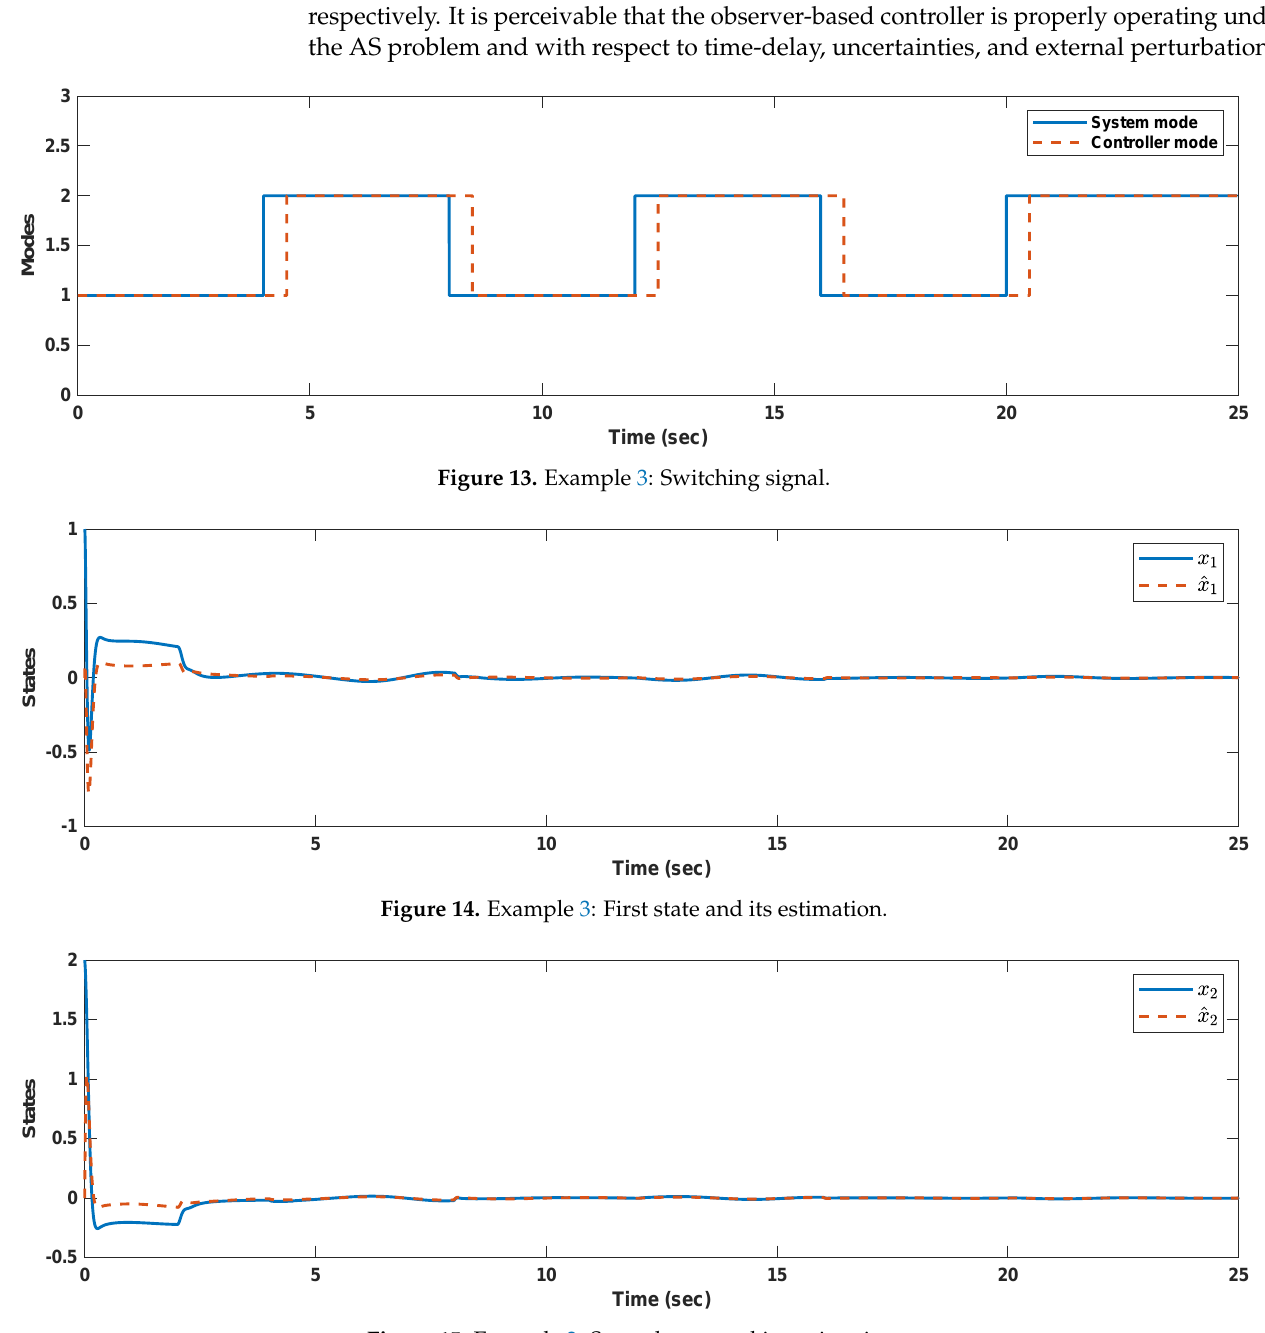
Figure 15. Example 3: Second state and its